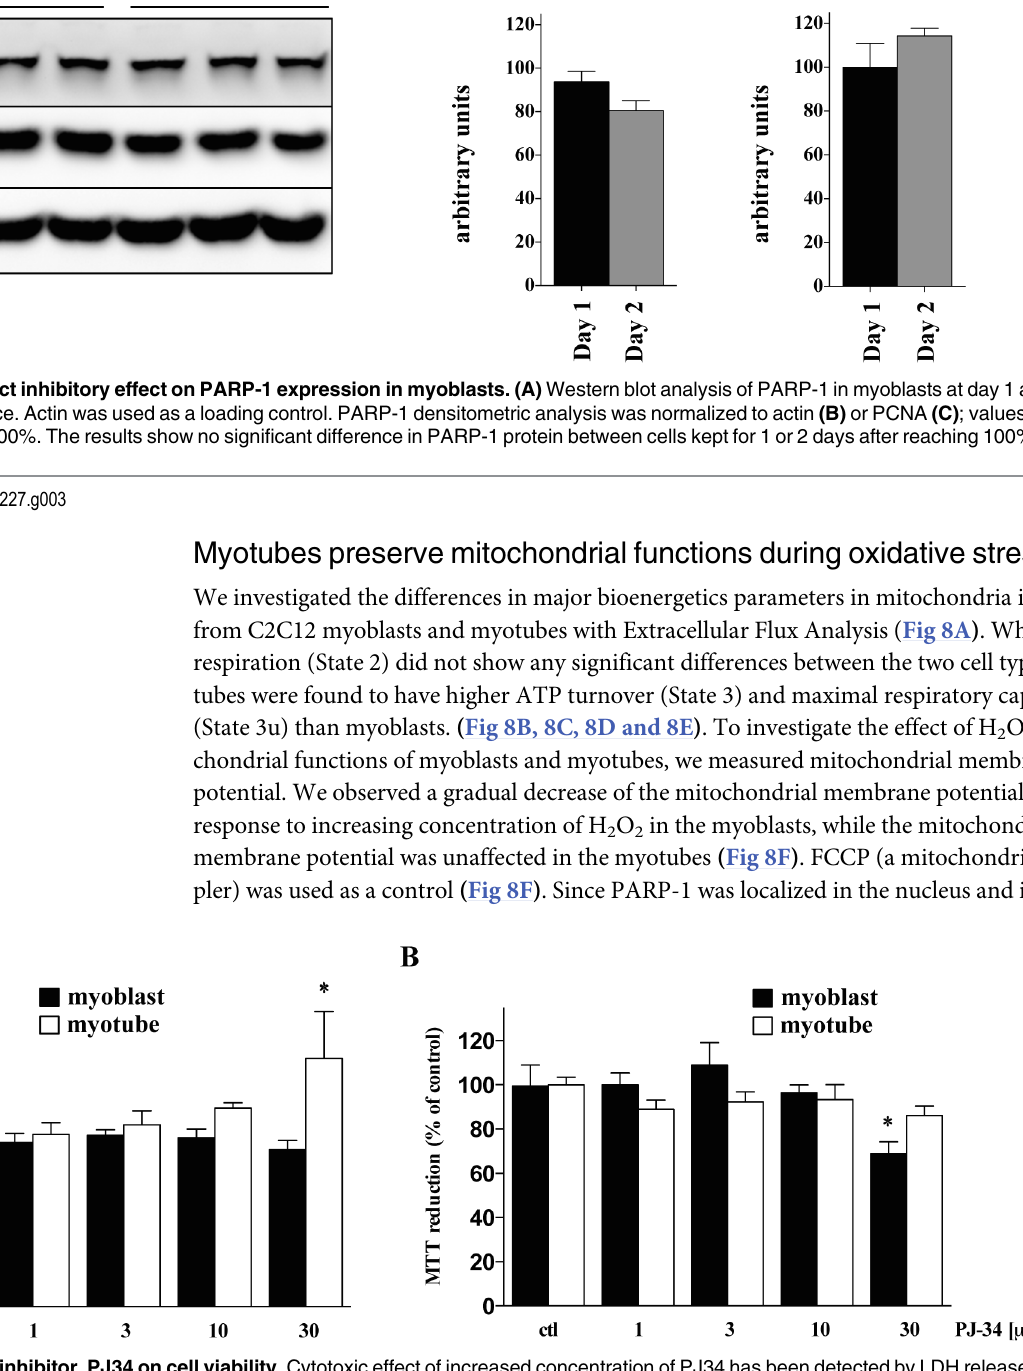
Fig 4. Effect of PARP-1 inhibitor, PJ34 on cell viability. Cytotoxic effect of increased concentration of PJ34 has been detected by LDH release (A) and MTT conversion assays (B) . The highest concentration of PJ34 without cytotoxic effect was 10 μ M. Data are shown as mean ± SD of 3 repeats. * shows significant difference, p < 0.05, in the cell response to PJ34 relative to controls. Data shown in A , B were calculated as percentage of control cells (untreated myoblasts or myotubes, in each case set as 100%).